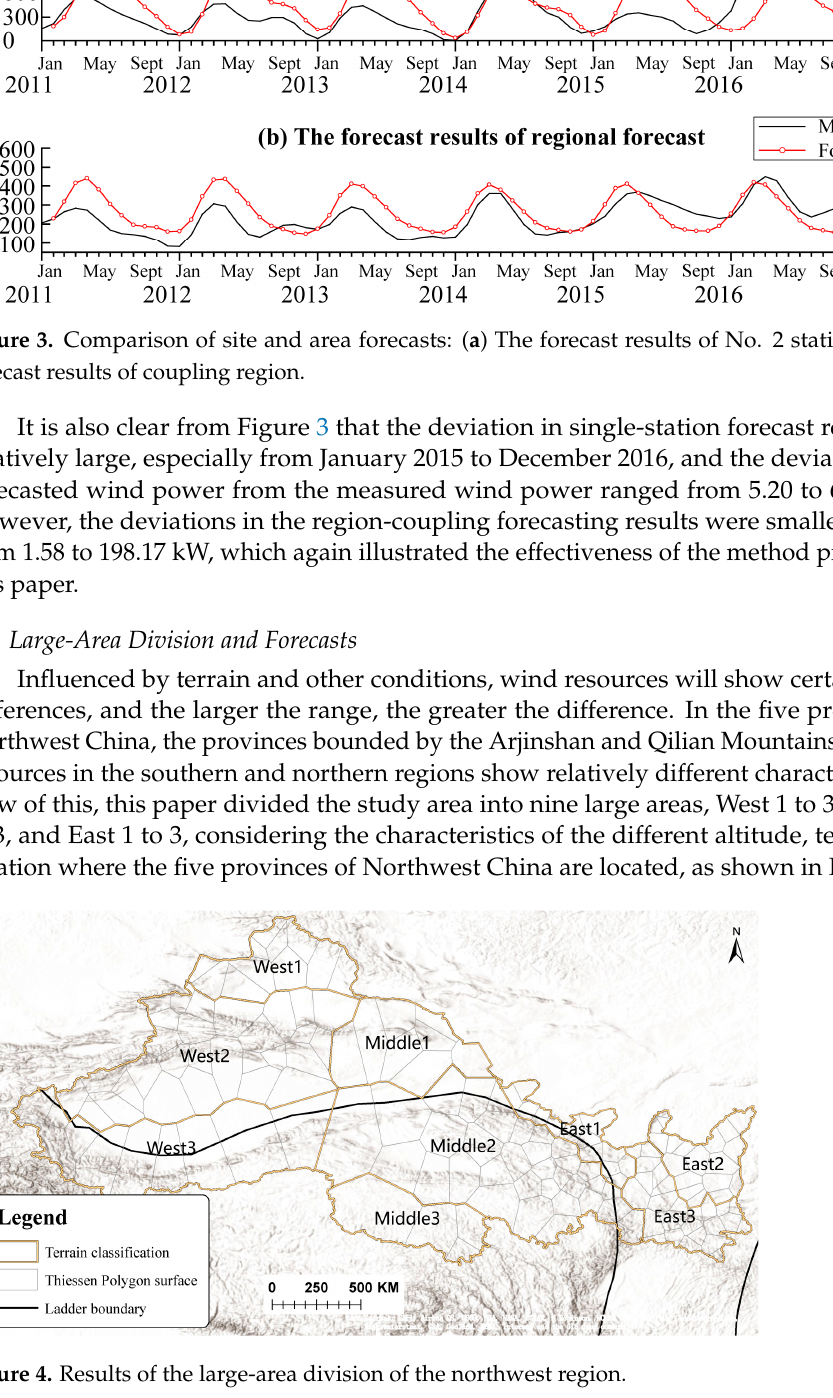
Figure 5. Forecast results based on large-area partition ( a , b ). As can be seen from Figure 5, the RMSE (the average value of the RMSE of all single- station forecasts in the sub-region) for the nine sub-regions ranged from 61.98 to 189.37 kW, while the RMSE of the regional forecast was smaller, ranging from 20.50 to 106.38 kW, with a percentage-reduction range of 18.64% to 74.59%. The average RMSE value is reduced from the original 115.64 kW to 57.73 kW, with an average percentage reduction of 50.86%. The average values of the single-station forecast RMSE in the western, central, and eastern regions of the five provinces of Northwest China were 117.58 kW, 135.36 kW and 93.97 kW, respectively; the average regional-forecast-RMSE values were 45.56 kW,